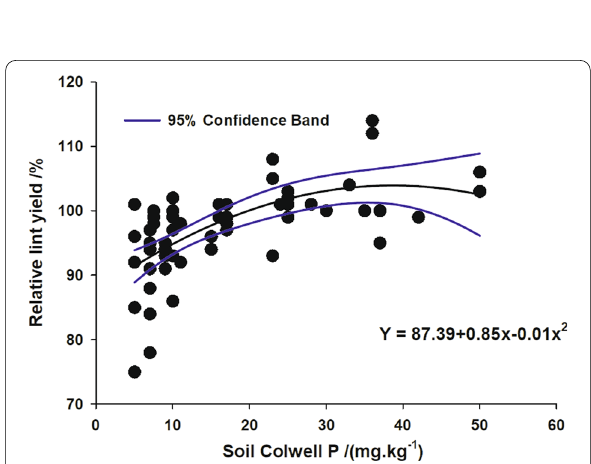
Fig. 3 Cotton lint yield response to fertiliser P as a function of soil Colwell P ( adapted from Hulme